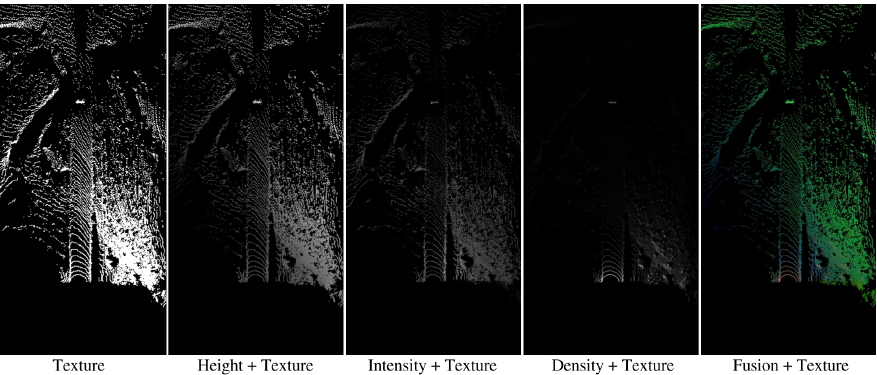
Figure 4. From left to right, the information stored in the five images is pure texture, height plus texture, reflection intensity plus texture, density plus texture, and fusion information plus